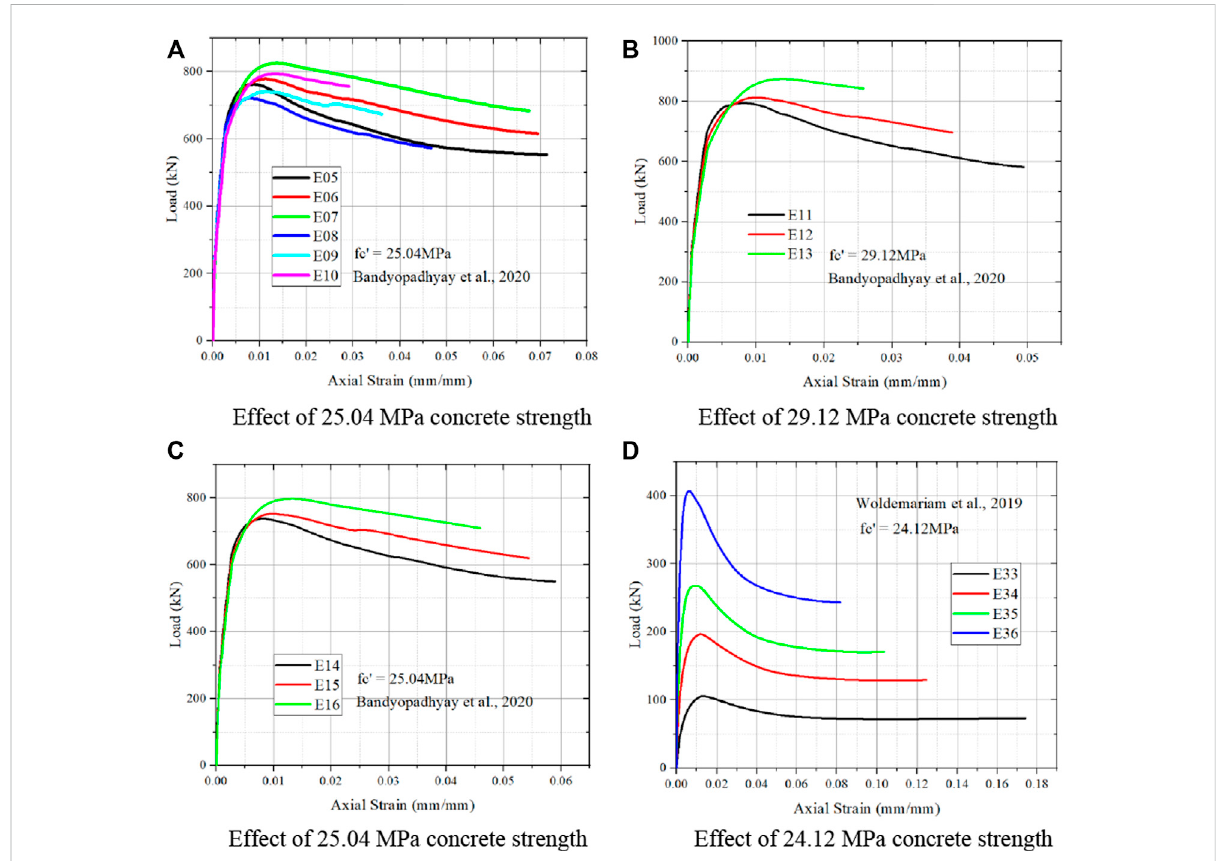
FIGURE 7 Effect of different concrete strength from Bandyopadhyay et al. (2020), Woldemariam et al. (2019). (A) Effect of 25.04 MPa concrete strength. (B) Effect of 29.12 MPa concrete strength. (C) Effect of 25.04 MPa concrete strength. (D) Effect of 24.12 MPa concrete strength.